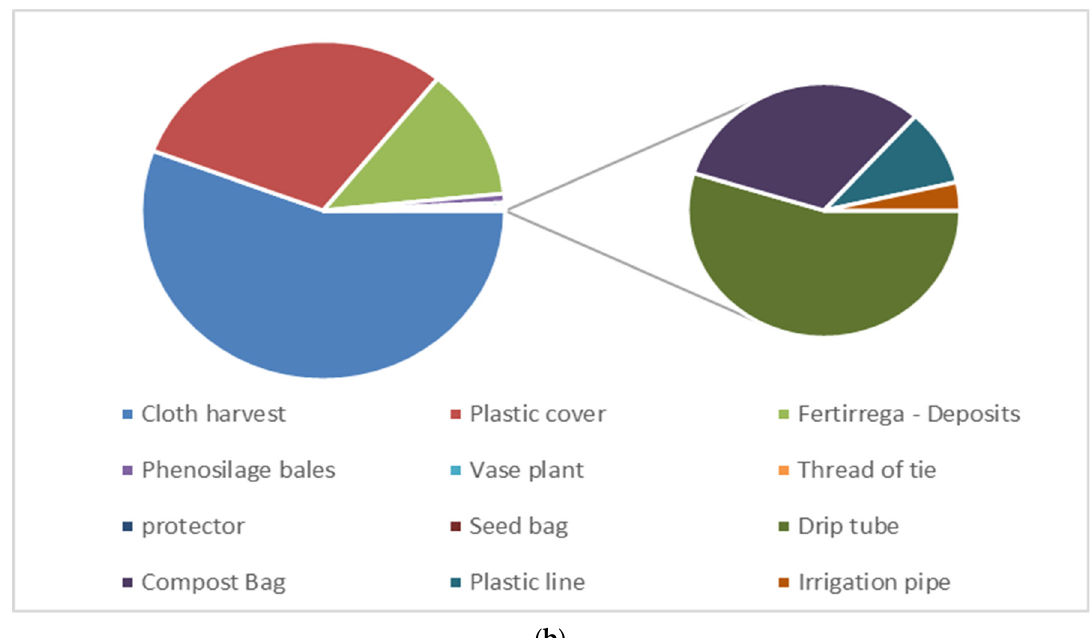
Figure 3. ( a ) Percentage amounts of the plastic used by culture type in the Alqueva irrigation area. ( b ) Percentage amount of each kind of plastic used by culture type in the Alqueva irrigation area.